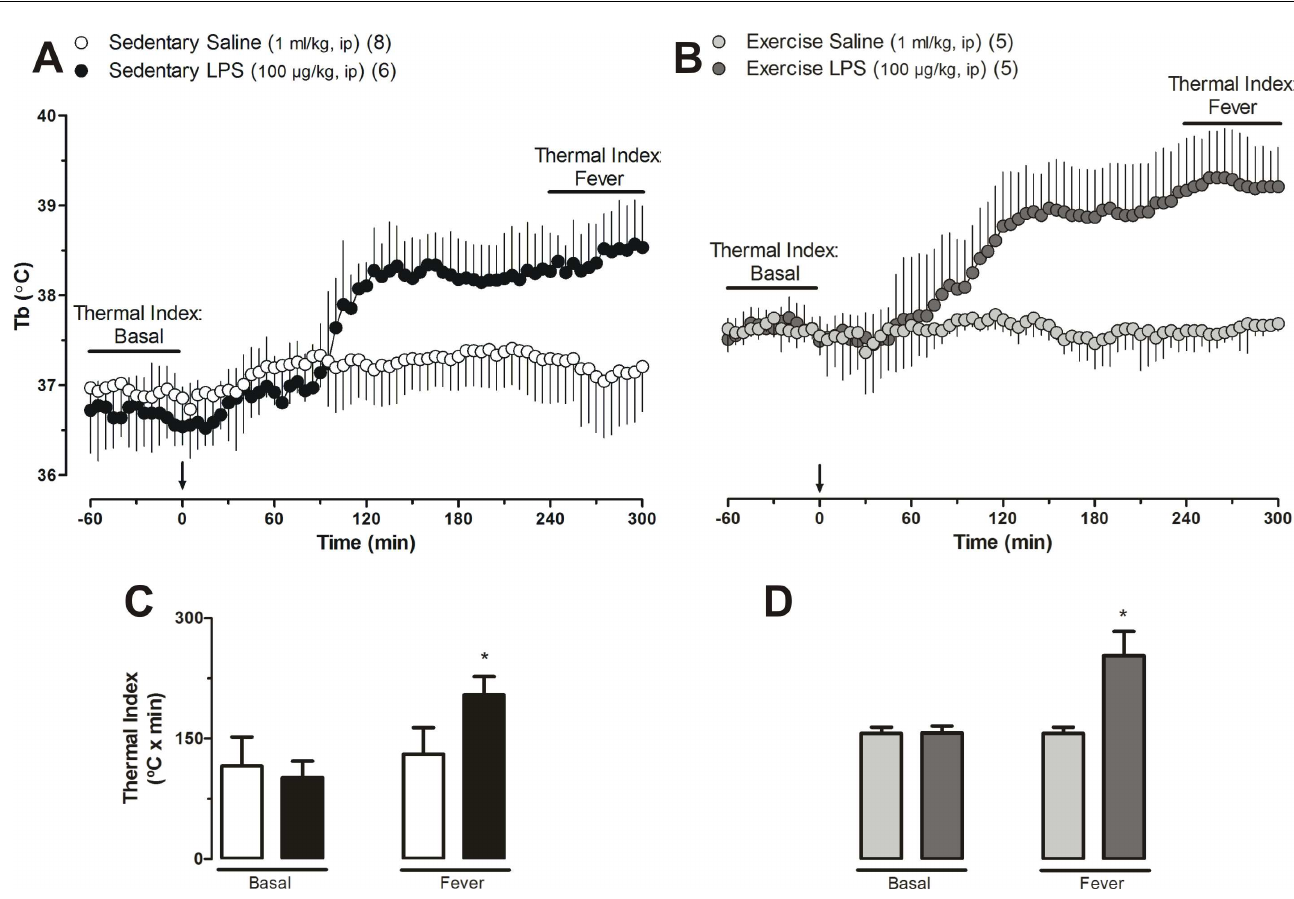
Fig 1. Time courses of deepbody temperature (Tb) of sedentary(A) and trained (B) rats showingthe effects of systemic LPS administration. Thermal indexes(C and D) of basal and febrile periods clarify the data shown by the horizontalbars in the panels A and B respectively.Arrow indicatesthe moment of the ip injectionof LPS or saline. Values are means ± SD. Number of animalsin each group is shown in parenthesis. * P < 0.05,Groups treated with LPS vs. the respectivecontrol